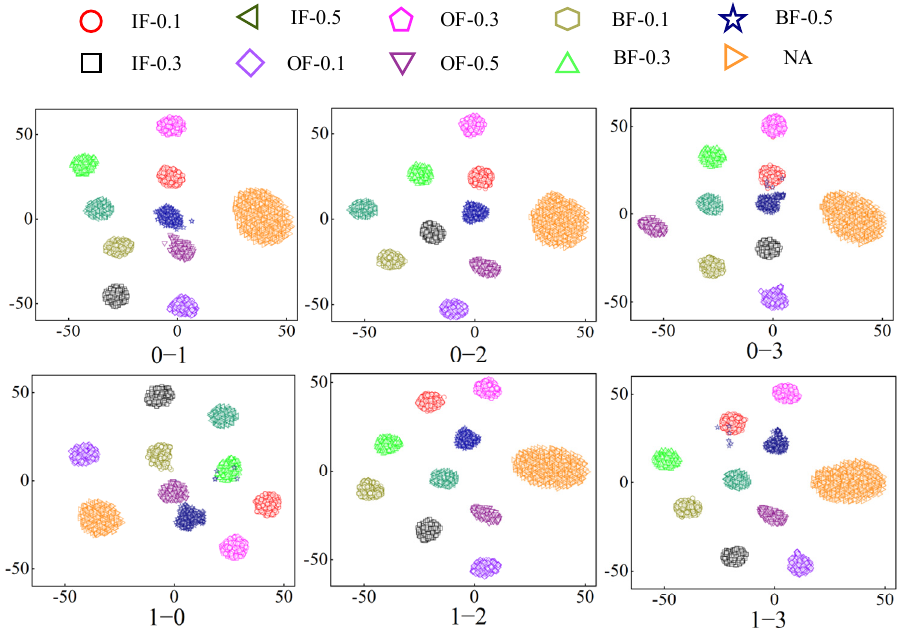
Figure 8. Feature visualization 1.